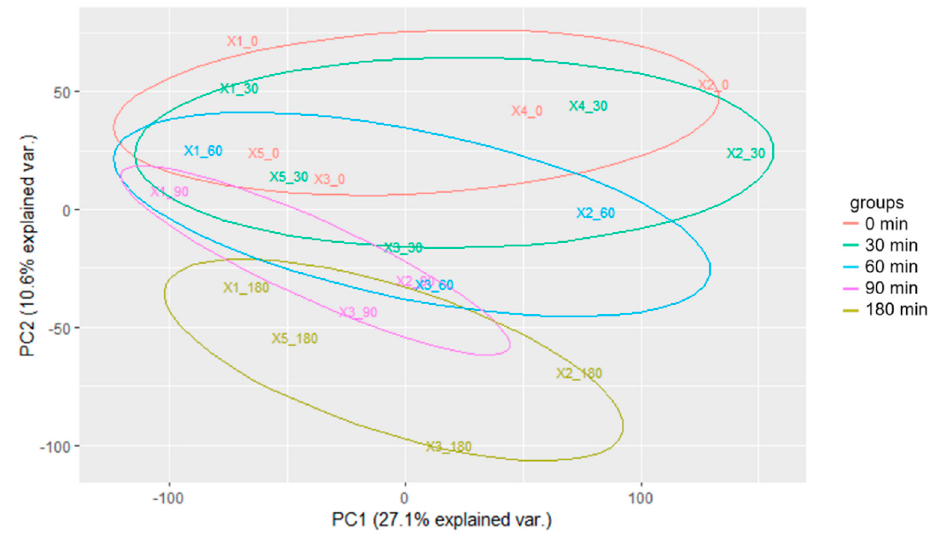
Figure 2. PCA plot demonstrating the increasing divergence of the transcriptome relative to the start of the experiment with increasing exposure time (PC2). Transcriptomic data generated from worms were used, which were exposed to a subtoxic dose of 100 mM MnCl 2 for 0, 30, 60, 90 and 180 min. Samples in the PCA plot are indicated by the number of the replicate followed by the exposure time to MnCl 2 . Additionally, samples are color coded to highlight replicates of the same exposure time according to the color legend.